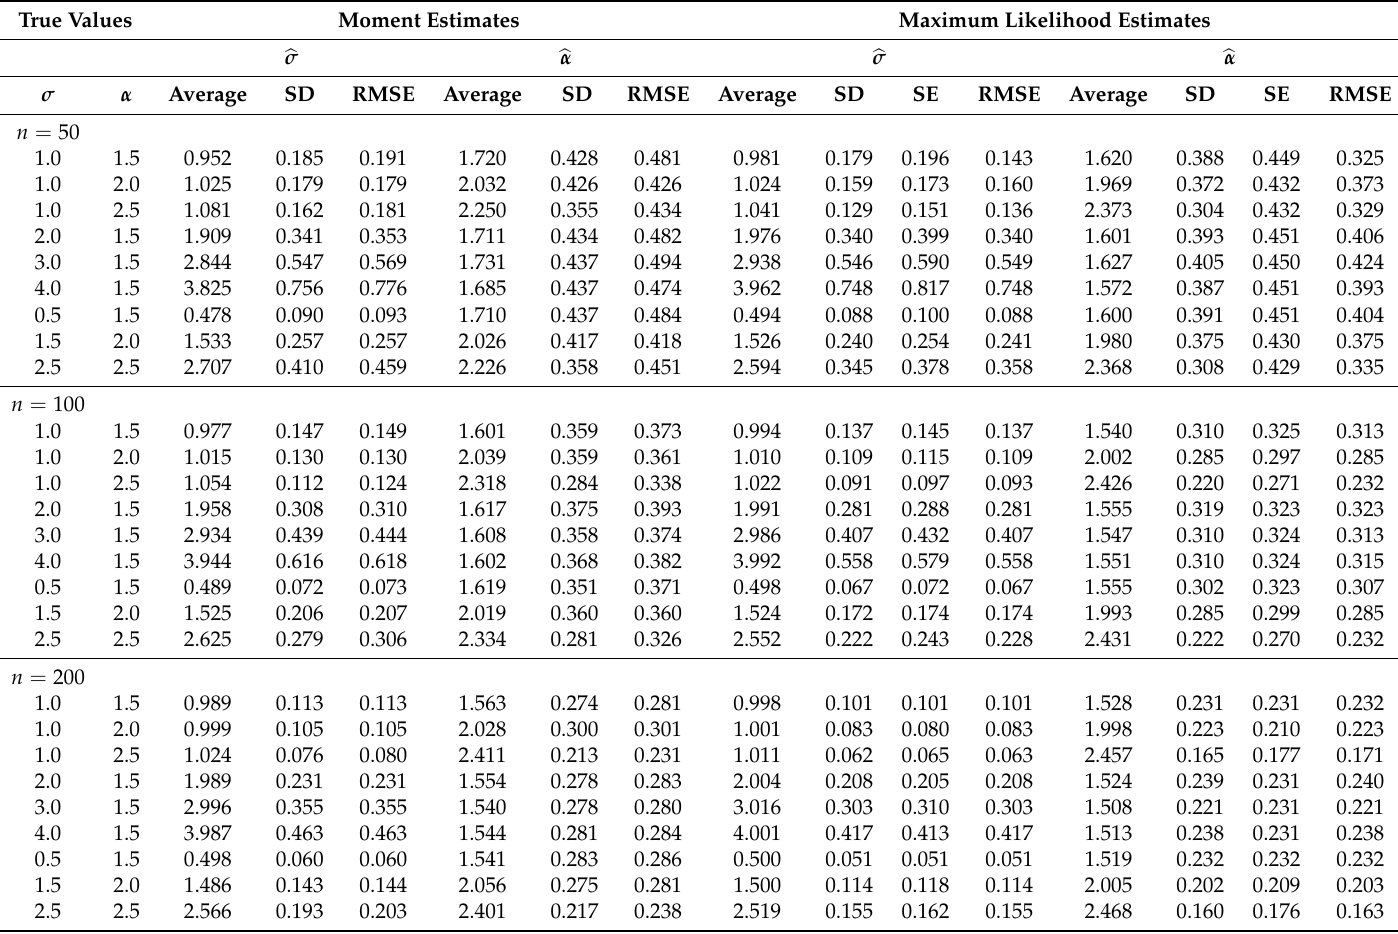
Table 4. Averages, standard deviations (SD), averages of asymptotic standard errors (SE) and roots of the simulated mean square errors (RMSE) for the estimates of σ and α for the LE